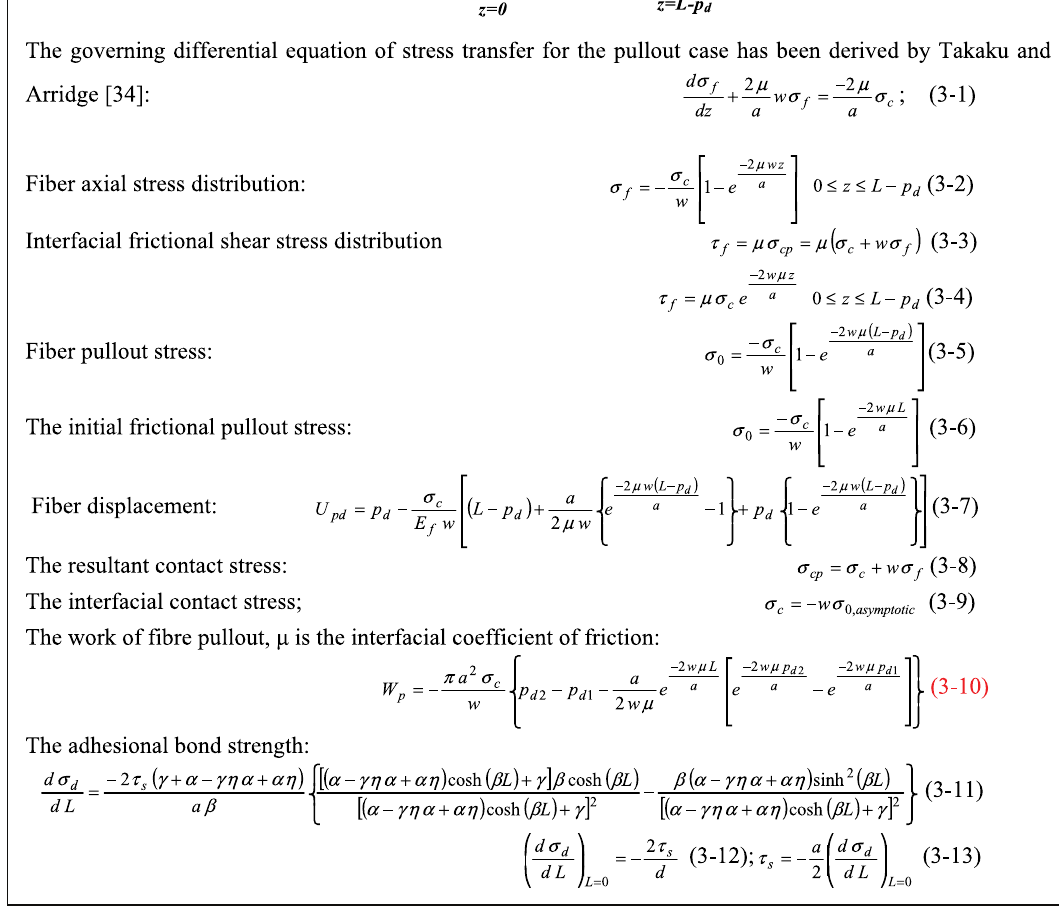
Figure 3. Stage 3 – fiber completely debonded over its embedded length and pulling out with the relevant calculations.